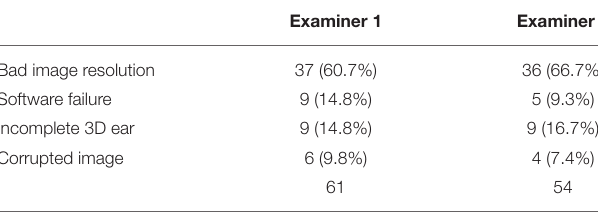
TABLE 1 | Reasons for trajectory planning